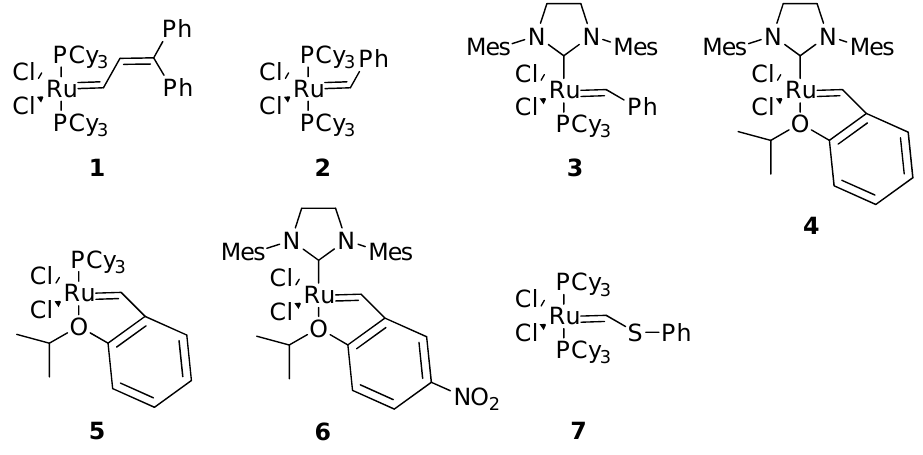
Figure 2. The most commonly used metathesis precatalysts for RCM in peptidic